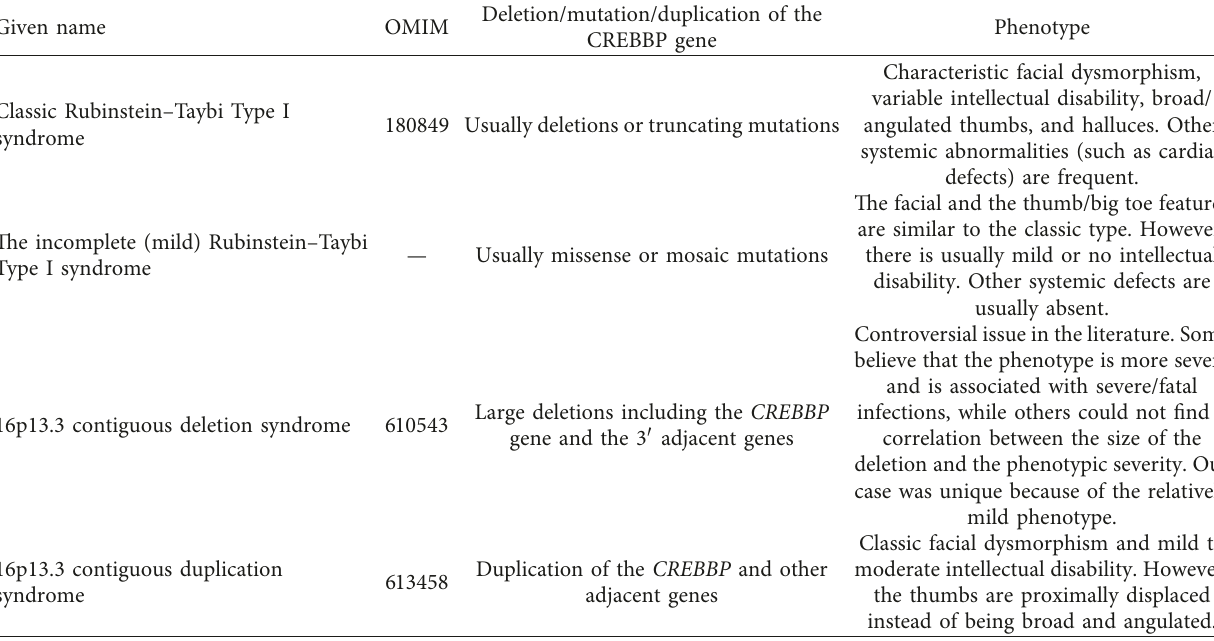
Table 2: Phenotypes related to the CREBBP